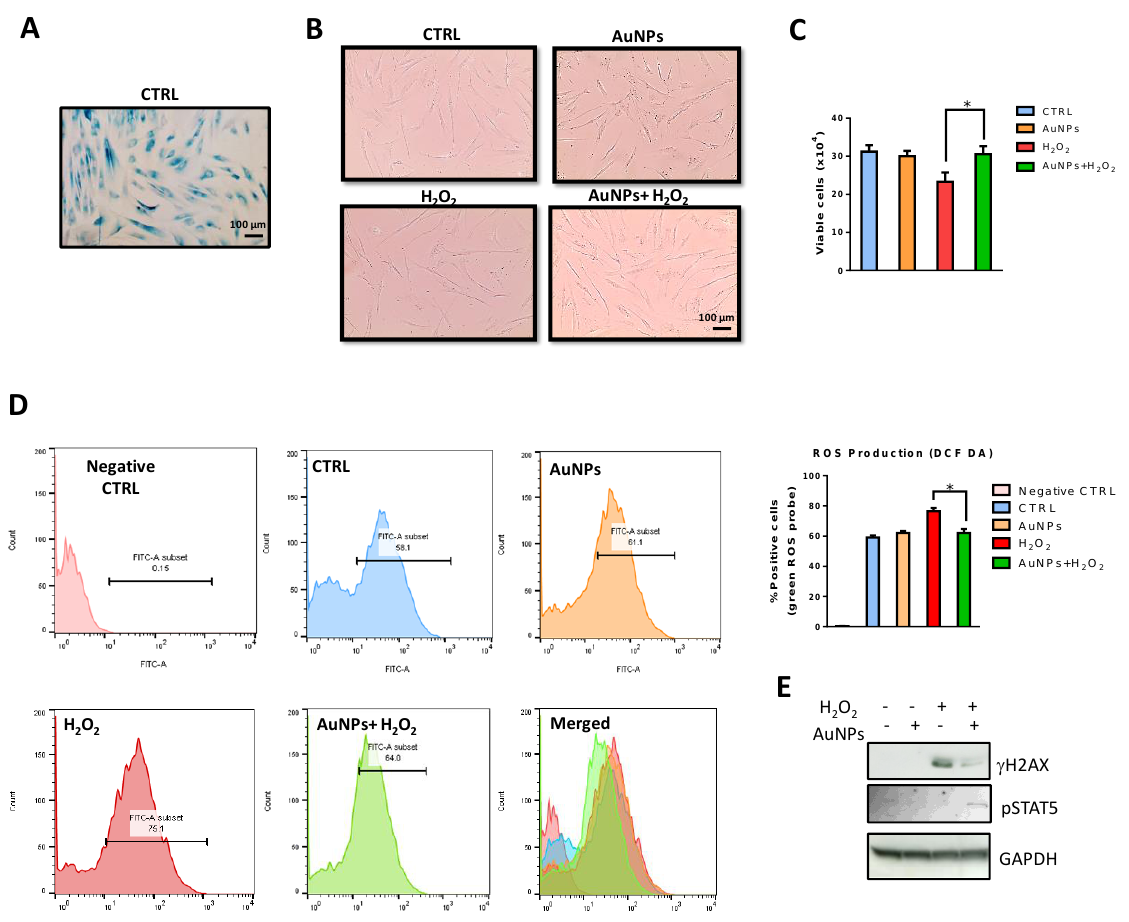
Figure 8. Effects of AuNPs in H 2 O 2 -exposed NHDFs. ( A ) Representative phase-contrast photomicrographs of SA- β -Gal positive cells. ( B ) Fibroblast morphology before and after treatments. Images are representative of cell cultures photographed using a phase-contrast microscope (100× magnification). ( C ) Histograms reporting viable cells (trypan blue negative) ( D ) Intracellular ROS scavenging activity of AuNPs in H 2 O 2 -exposed NHDFs. Histograms represent the percentage of cells positive for the DCF-DA probe. ( E ) Effects of AuNPs on H2AX and STAT5 phosphorylation were evaluated by western blot analysis. Data are presented as the mean ± standard deviation from triplicate experiments. * p < 0.05, compared with H 2 O 2 -treated cells.